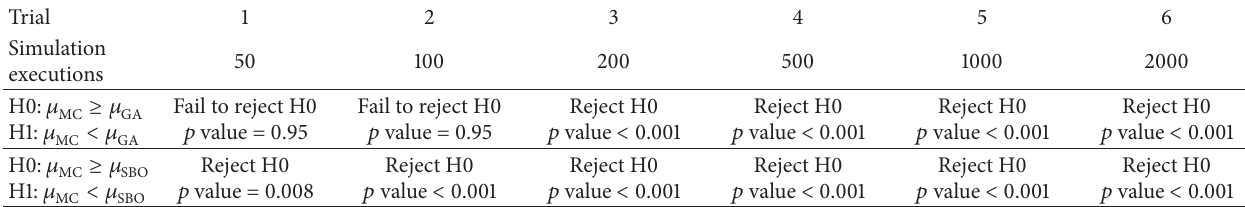
Table 3: Results of statistical hypothesis testing for maximum lateral deviation.